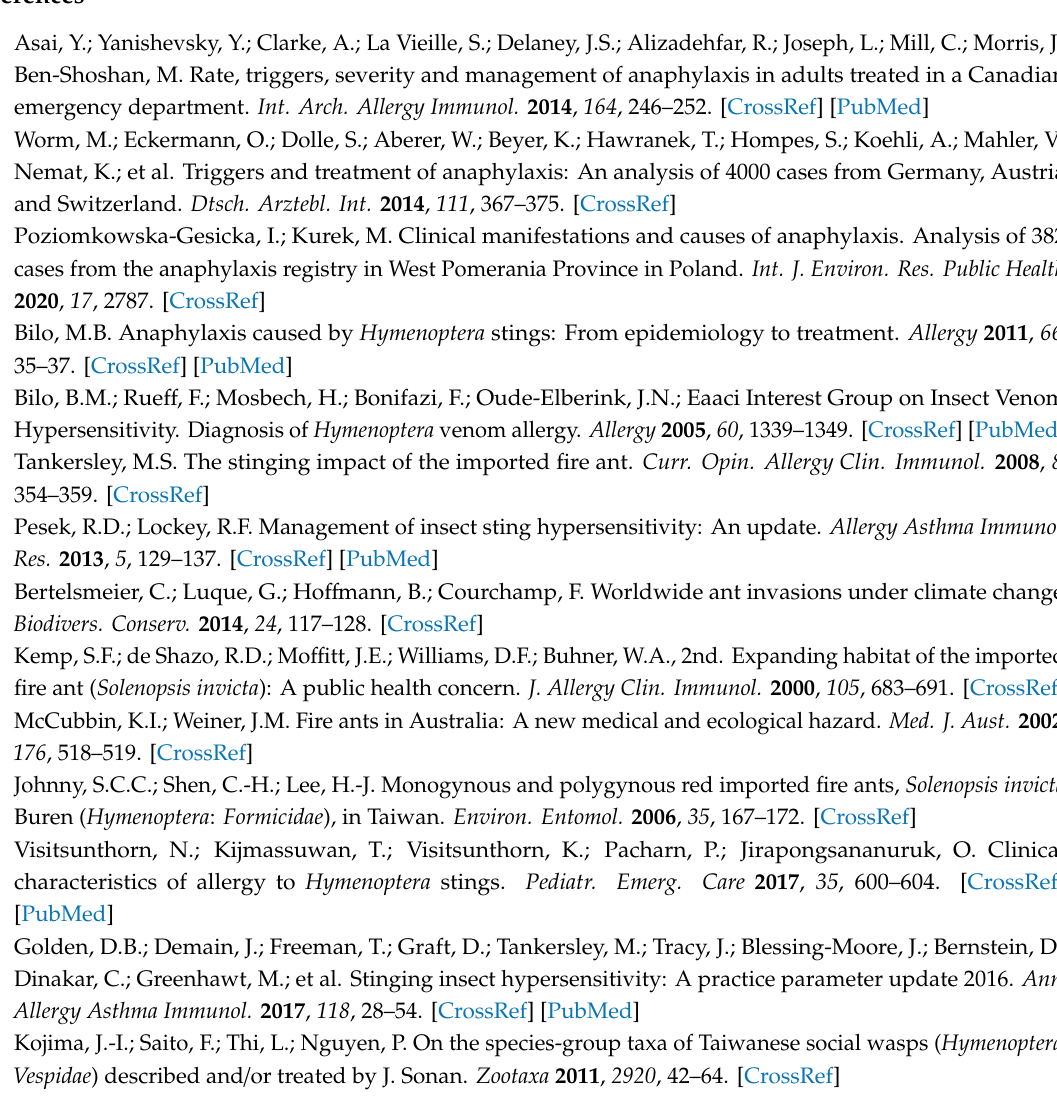
Figure S1: (A) Scatter plot with number of cases vs. average temperature in two groups and (B) scatter plot with number of cases vs. relative humidity in two groups, Table S1: Medication used to treatment in this study. Author Contributions: Conceptualization, Y.-Y.L., C.-C.C., and C.-P.C.; data collection, Y.-Y.L., H.-A.C.,